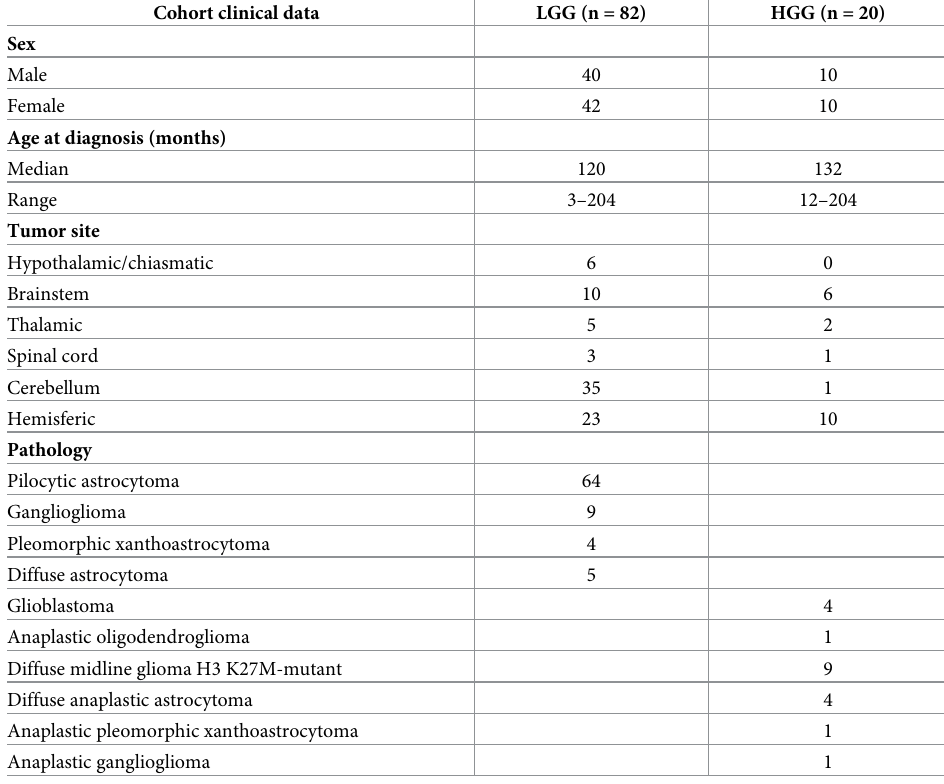
Table 2. Demographic, clinical, and histological patient